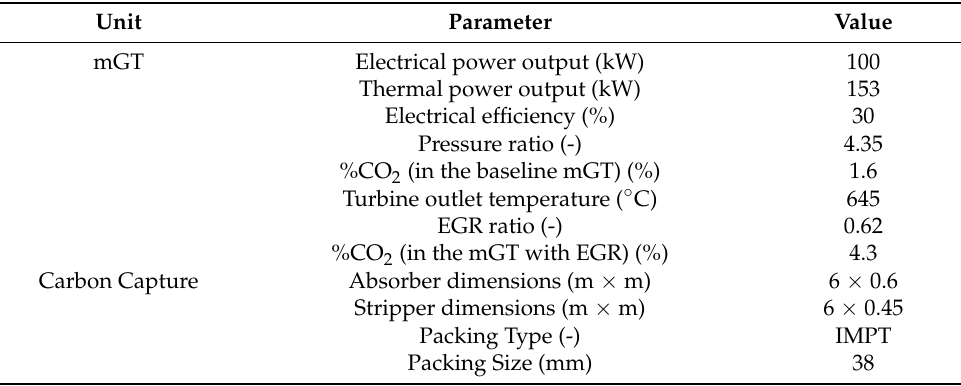
Table 1. Key design conditions of the mGT and CC plant (adapted from [67]).